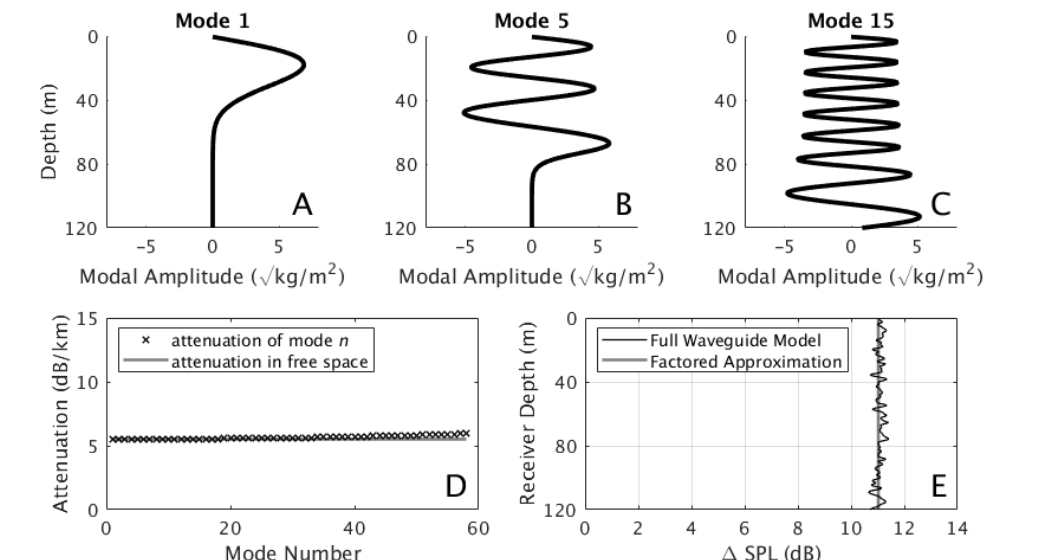
Figure 2. When an occluding fish shoal is uniformly distributed through the water column, attenuation in a waveguide has a form similar to that in free space in that the effect of attenuation appears as a single exponential factor in received intensity, as in Equation (14). In the example shown here, attenuation of each propagating mode ( A – C ) differs from free space attenuation by less than 0.5 dB/km ( D ) and the decrease in sound pressure level due to attenuation ( ∆ SPL ) matches the free-space-like factored approximation within 0.5 dB at any receiver depth ( E ). Here, attenuation during one-way propagation is modeled for Ålesund herring with expected scatter function (cid:104) S (cid:105) = − 0.03 + 0.10 i in a shoal uniformly distributed between the sea surface and the seafloor (0–120 m) with width 2 km and areal population density 2.5 fish/m 2 estimated from echosounding data, with a source at depth 60 m with frequency 955 Hz and Ålesund sound speed profiles shown in Appendix F. Water density is modeled as 1000 kg/m 2 , seafloor density as 1900 kg/m 2 and seafloor sound speed as 1700